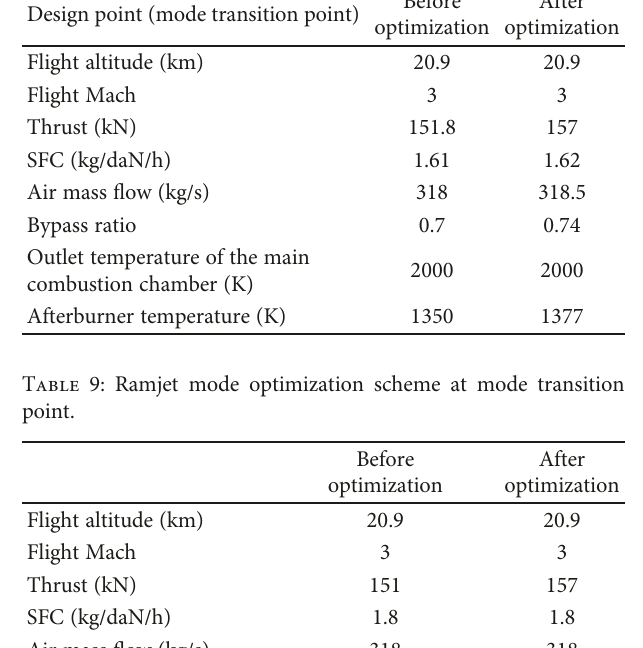
Table 8: Turbofan mode optimization scheme. Table 10: Turbofan mode optimization scheme. Before Design point (mode transition point) Take-o ff operating point